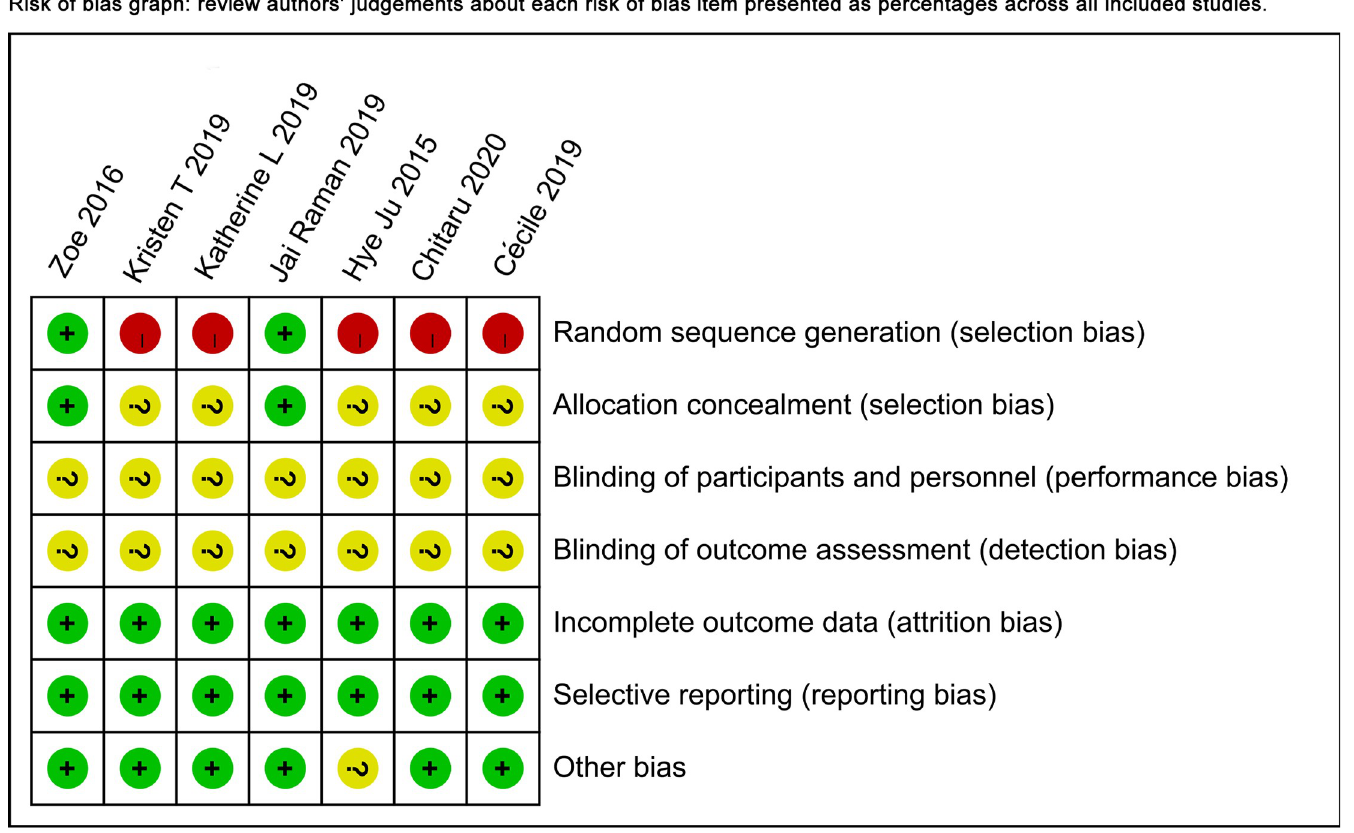
PLOS ONE | https://doi.org/10.1371/journal.pone.0249854 April 8,